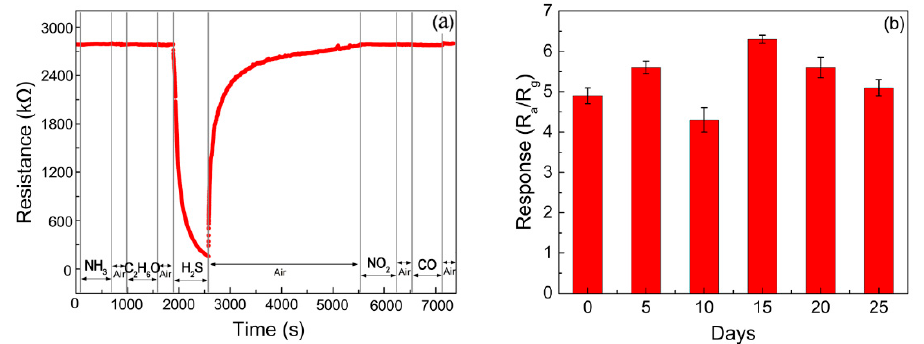
Figure 8. ( a ) Dynamic response curves of NiO/ZnO-heterostructures-based sensor to H 2 S and other gases (NH 3 , C 2 H 6 O, NO 2 , and CO) for the same concentration of 20 ppm was measured at 160 °C; ( b ) Stability of NiO/ZnO-heterostructures-based sensor to 1 ppm H 2 S at 160 °C.